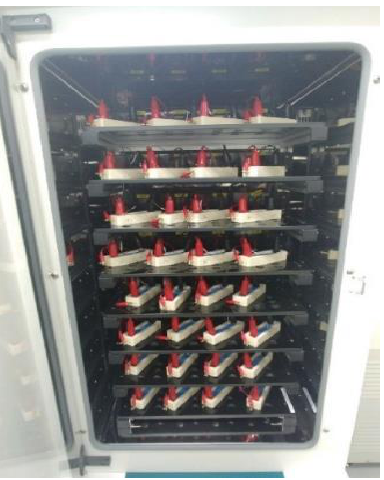
Figure 5. Cells in a temperature chamber being cycled to derive WDF.